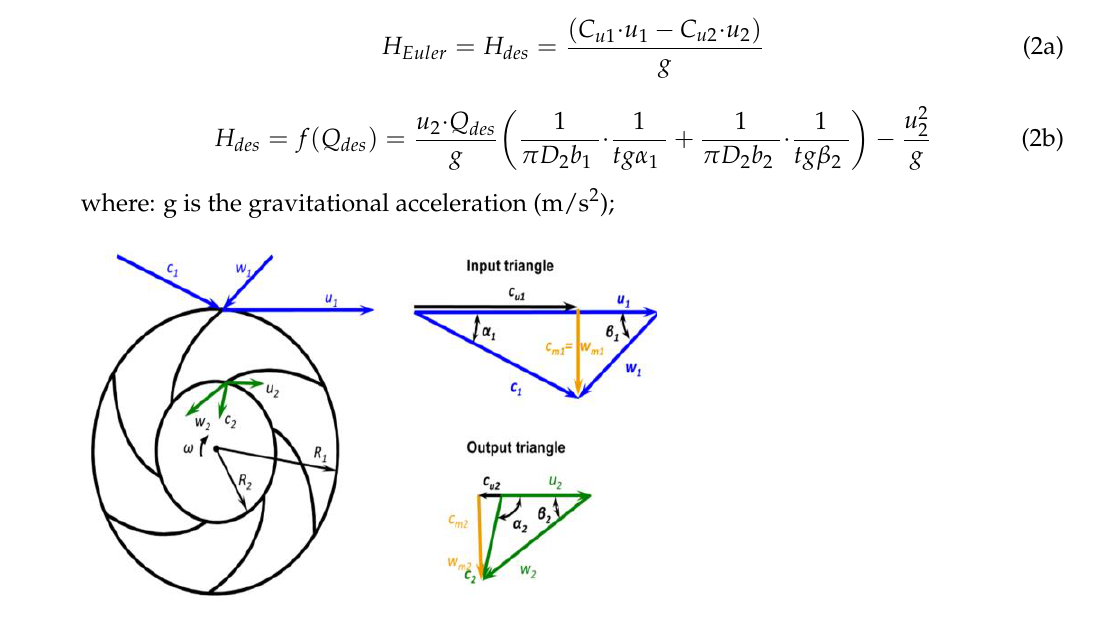
Figure 2. Basic form of inlet and outlet velocity triangles of a typical reaction turbine [31]. c u 1 , c u 2 is the tangential component of the absolute blade velocity at turbine inlet and outlet velocity triangles (m/s); Q des is the design flow rate (m 3 /s); D 2 is the outlet runner diameter